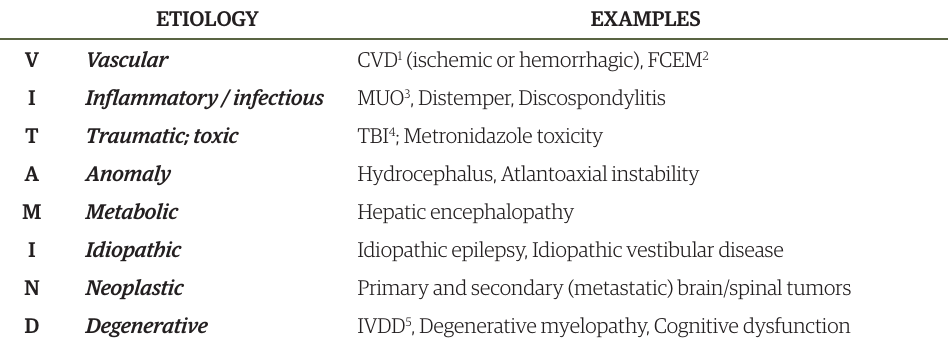
table 1. Description of the VITAMIN-D acronym based on pathophysiologic mechanisms of neurologic diseases in small animals (Dewey & Da Costa